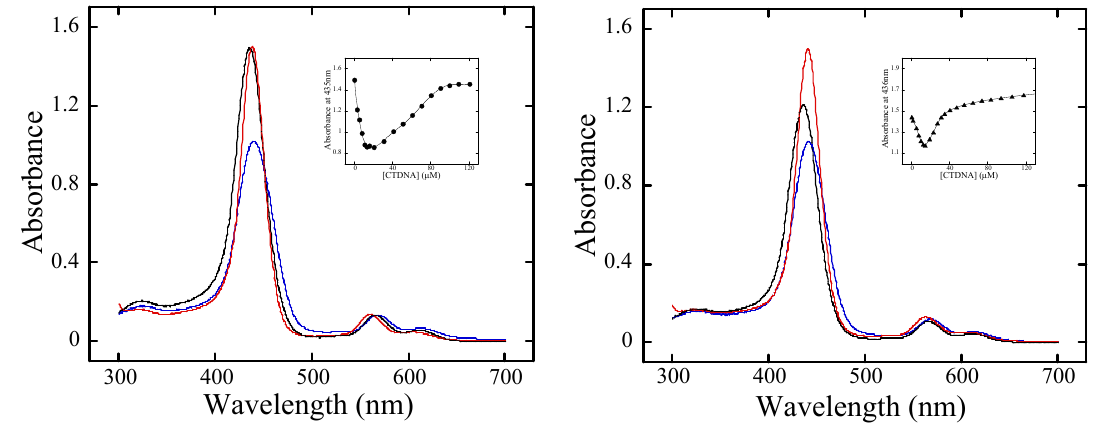
Figure 3 . ( a , left) Absorption spectral change of ZnpXy (3.5 μ M) with addition of CTDNA (black, 0 μ M; blue, 12.9 μ M; red, 128 μ M) and absorbance change at 435 nm, ( b , right) absorption spectral change of ZnpXy (3.5 μ M) with addition of CTDNA (black, 0